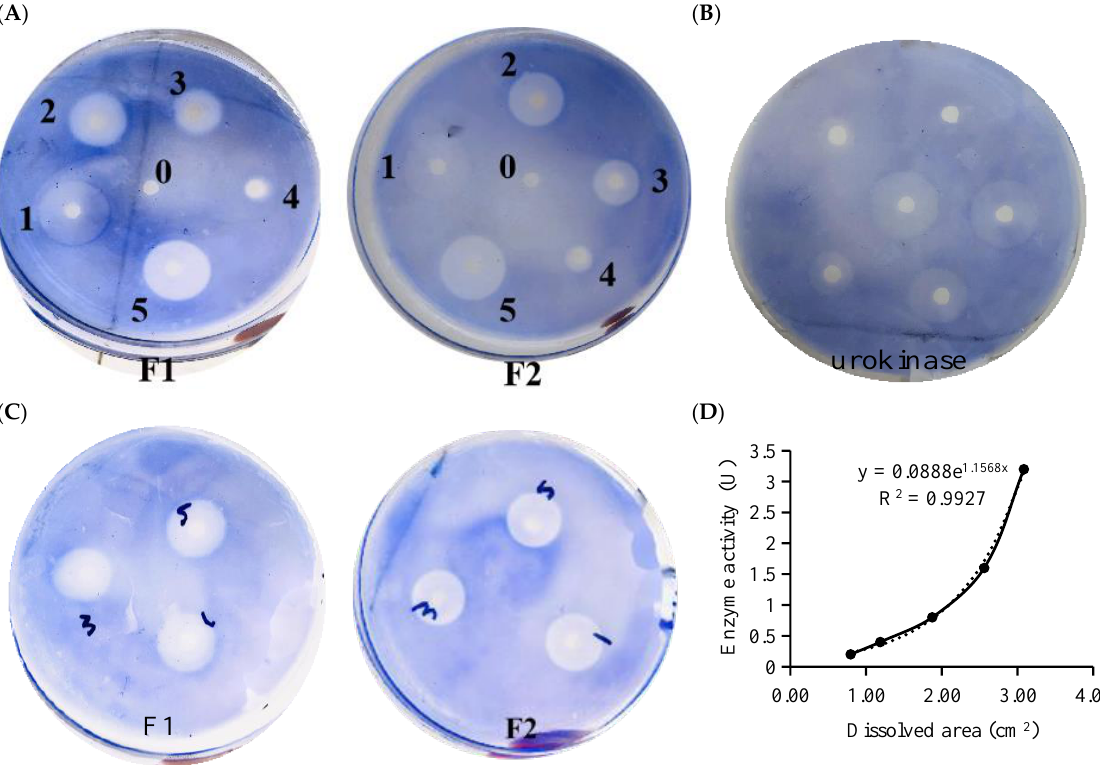
Figure 7. Fibrinolysis evaluation of F1 and F2 in vitro, 0-PBS, 1–200 U/mL Urokinase, 2–10 mg/mL, 3–5 mg/mL, 4–1 mg/mL, 5-Hep 10 mg/mL ( A ). Dissolution ring area produced by different concentrations of urokinase ( B ). Results of 10 mg/mL dissolution circle of F1, F2 ( C ). Urokinase standard curve ( D ).